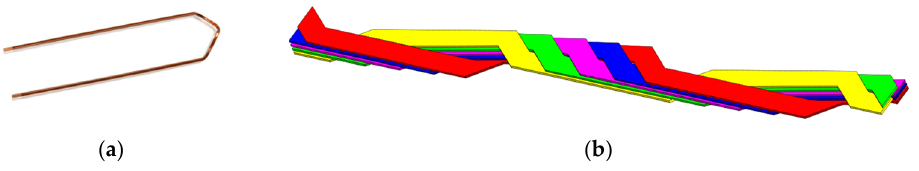
Figure 2. Hairpin stator windings. ( a ) A hairpin winding branch for low currents, reproduced with permission from the owner, Otto Bihler Maschinenfabrik GmbH & Co. KG (Germany) [96]; ( b ) half- bar comprising of five strands assembled upon the Roebel-transposition, which can be processed by AM [97].